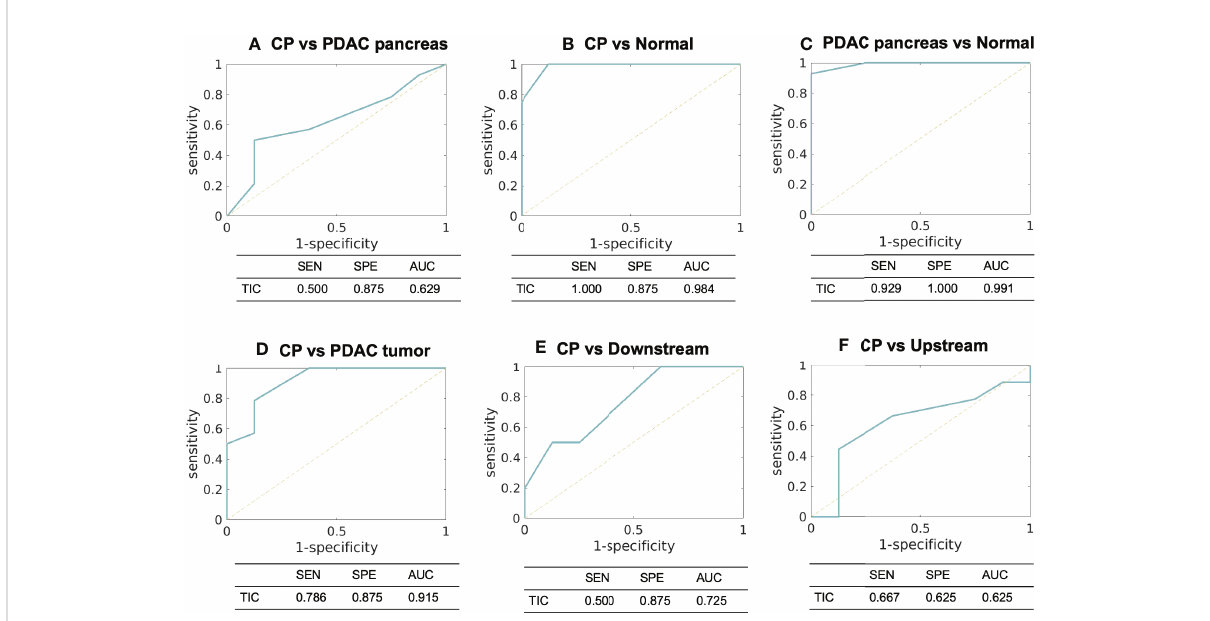
FIGURE 5 ROC curves and the sensitivity, speci fi city, and AUC using TIC analysis to differentiate between (A) CP versus PDAC pancreas, (B) CP versus normal control pancreas, (C) PDAC pancreas versus normal control pancreas, (D) CP versus PDAC tumor, (E) CP versus PDAC downstream, and (F) CP versus PDAC upstream. SEN, sensitivity; SPE, speci fi city; AUC, area under ROC curve; TIC, time-signal intensity